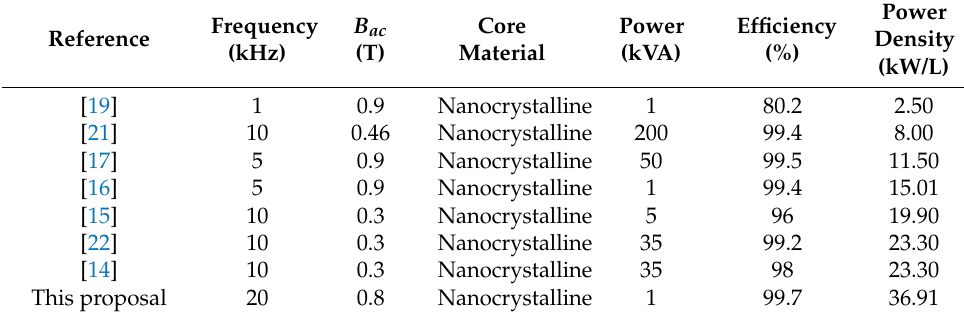
Table 1. Comparison of medium frequency transformers with nanocrystalline core.